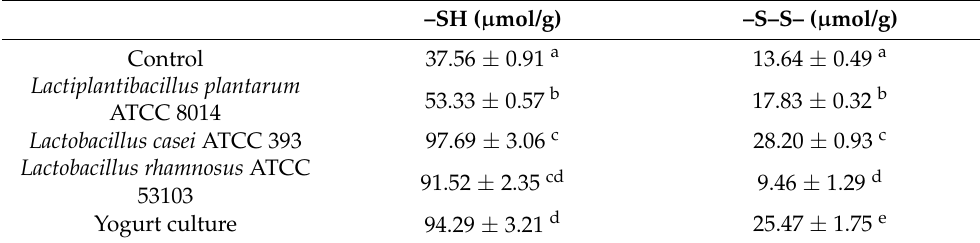
Table 3. Determination of Sulfhydryl Groups (–SH) and Disulfide Bonds (–S–S–). –SH ( µ